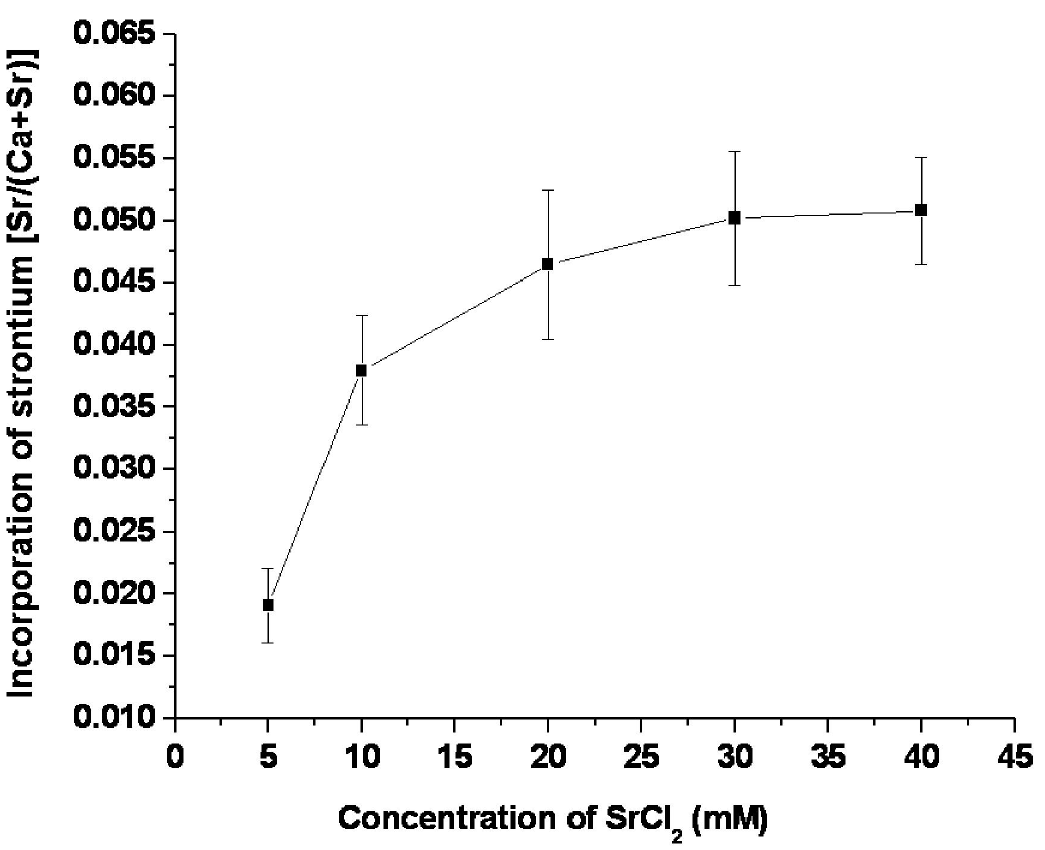
Figure 1. Incorporation of strontium in bone as a function of SrCl doi: